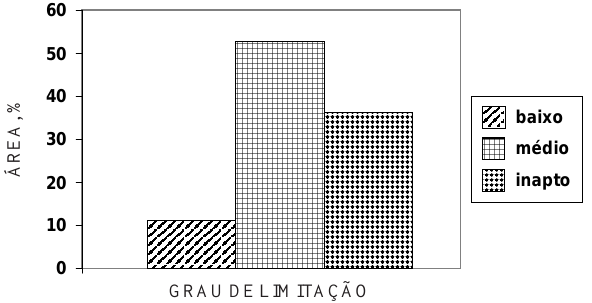
Figura 1. Graus de limitação por deficiência de fertilidade das terras de Goiás e do Distrito